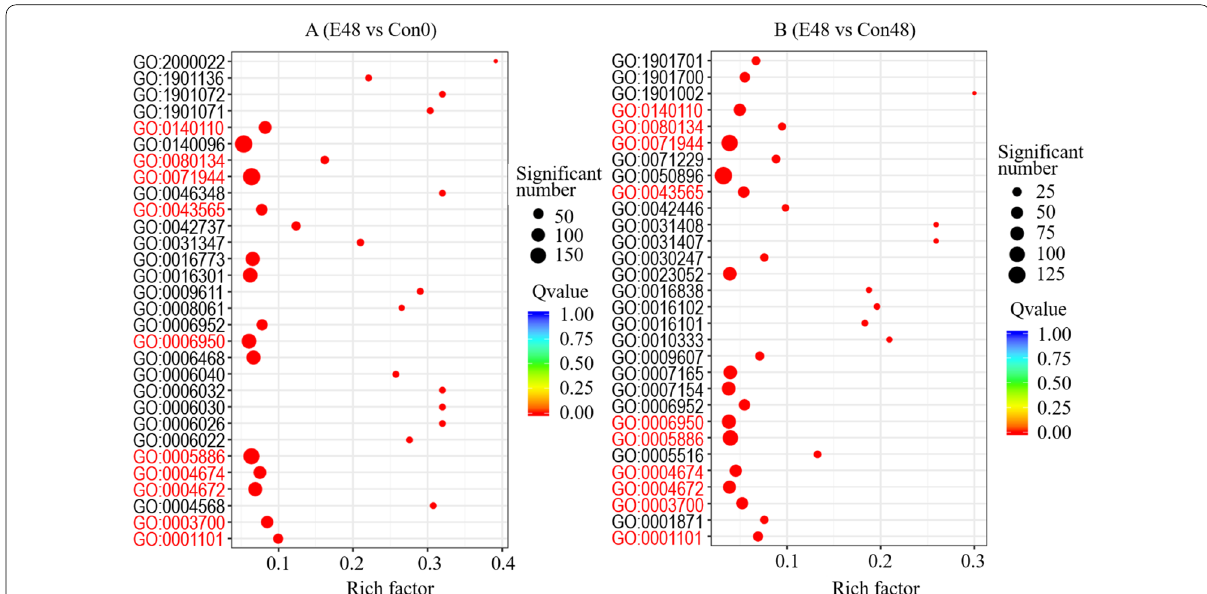
Fig. 7 Scatter diagram of GO classification of protein elicitor EsxA-induced up-regulated genes in